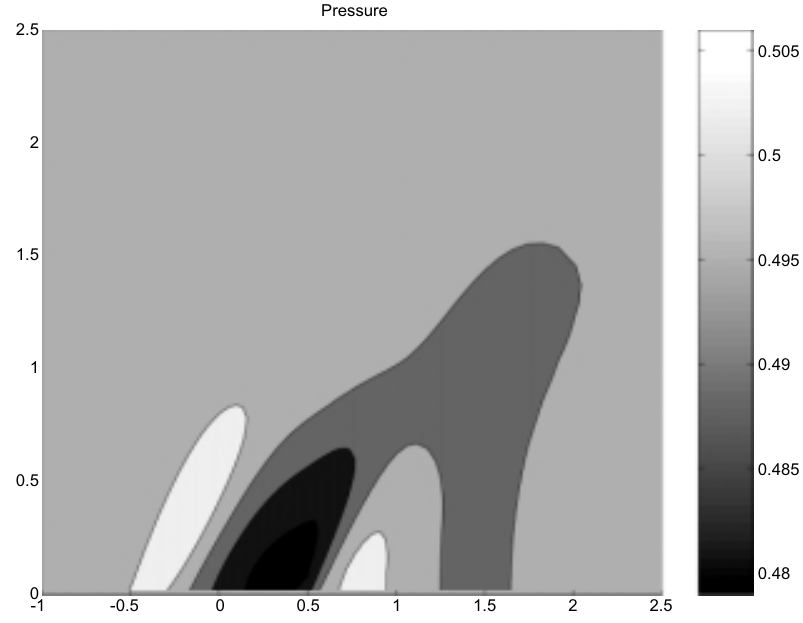
Fig. 10. Pressures after 20 second simulation using 8 modes with δ 1 = 0 . 005